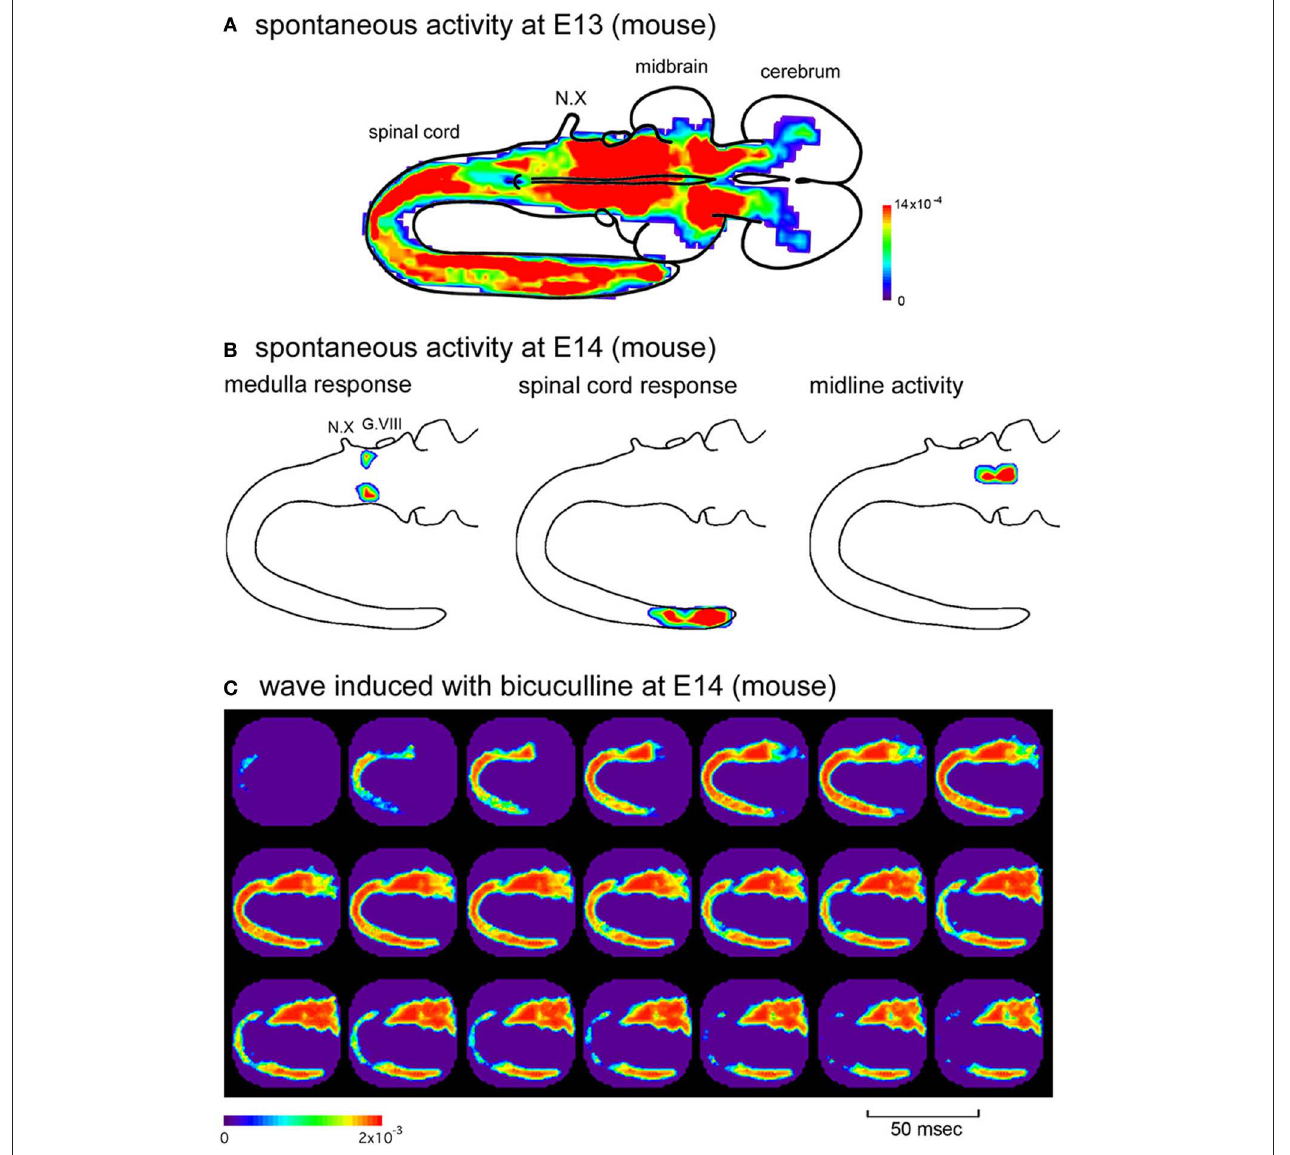
FIGURE 3 | (A) Color-coded representation of maximum signal amplitudes of the spontaneous activity in an E13 mouse embryo. (B) Spatial distribution of the spontaneous activity in an E14 mouse embryo. The activity was localized to restricted regions of the medulla (left), caudal spinal cord (middle), and midline of the brainstem (right), which corresponds to the parafacial respiratory group, central pattern generator of locomotion, and midline raphe, respectively. The maximum amplitude